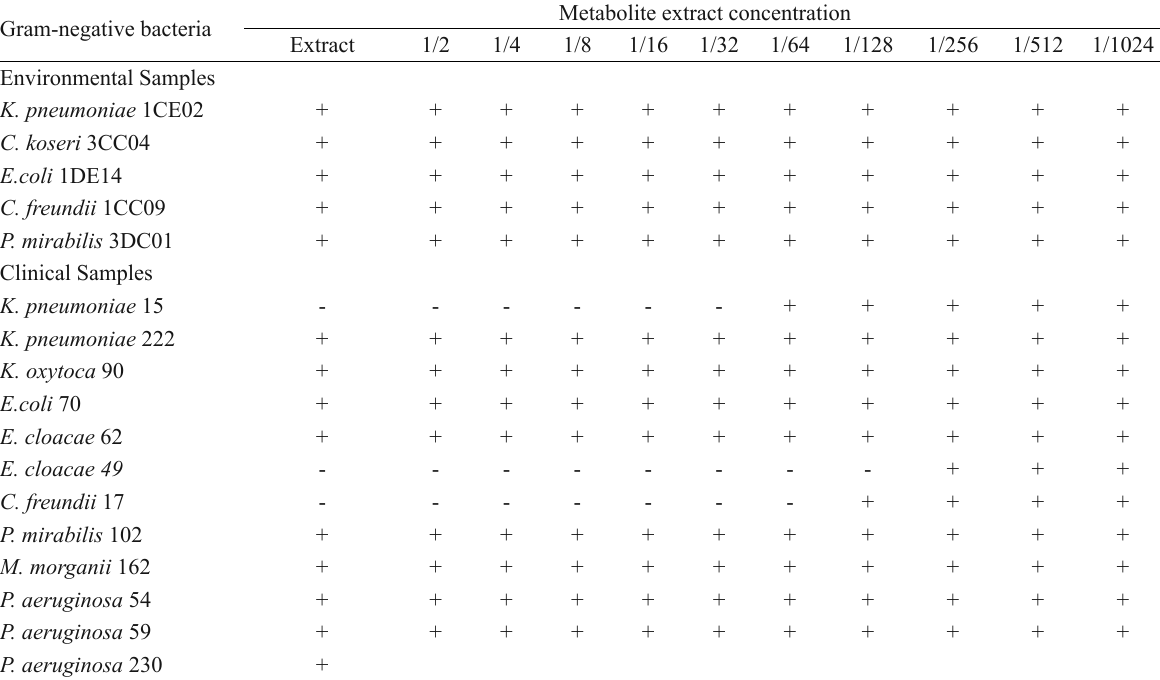
Results of the minimum inhibitory concentration (MIC) of the crude extract produced by the endophytic actinomycete R18(6) against environmental and clinical samples after 24 h of incubation.